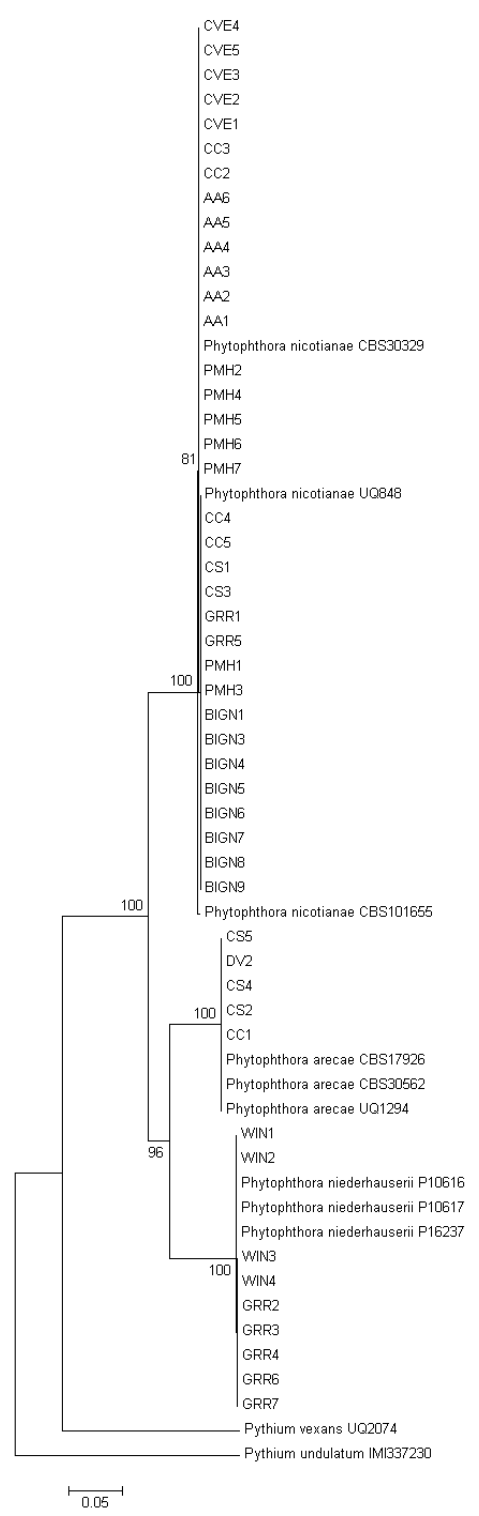
Figure 1. Molecular phylogenetic neighbour-joining tree based on inter- nal transcribed spacer ribosomal DNA sequence data from 48 Phytoph- thora isolates collected from ornamental host species in Italy. Three refer- ence strains for each species were also included, along with two Pythium species as outgroups. Bootstrap values are shown at branch nodes, and branch lengths represent the number of substitutions per site.